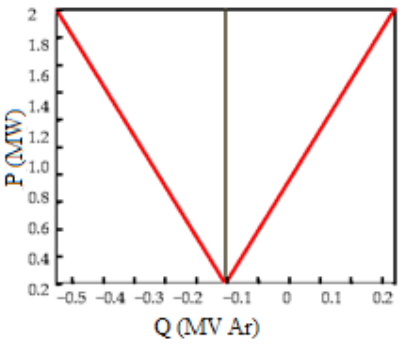
Figure 2. Q characteristic for WT in G80-2.0 MW.